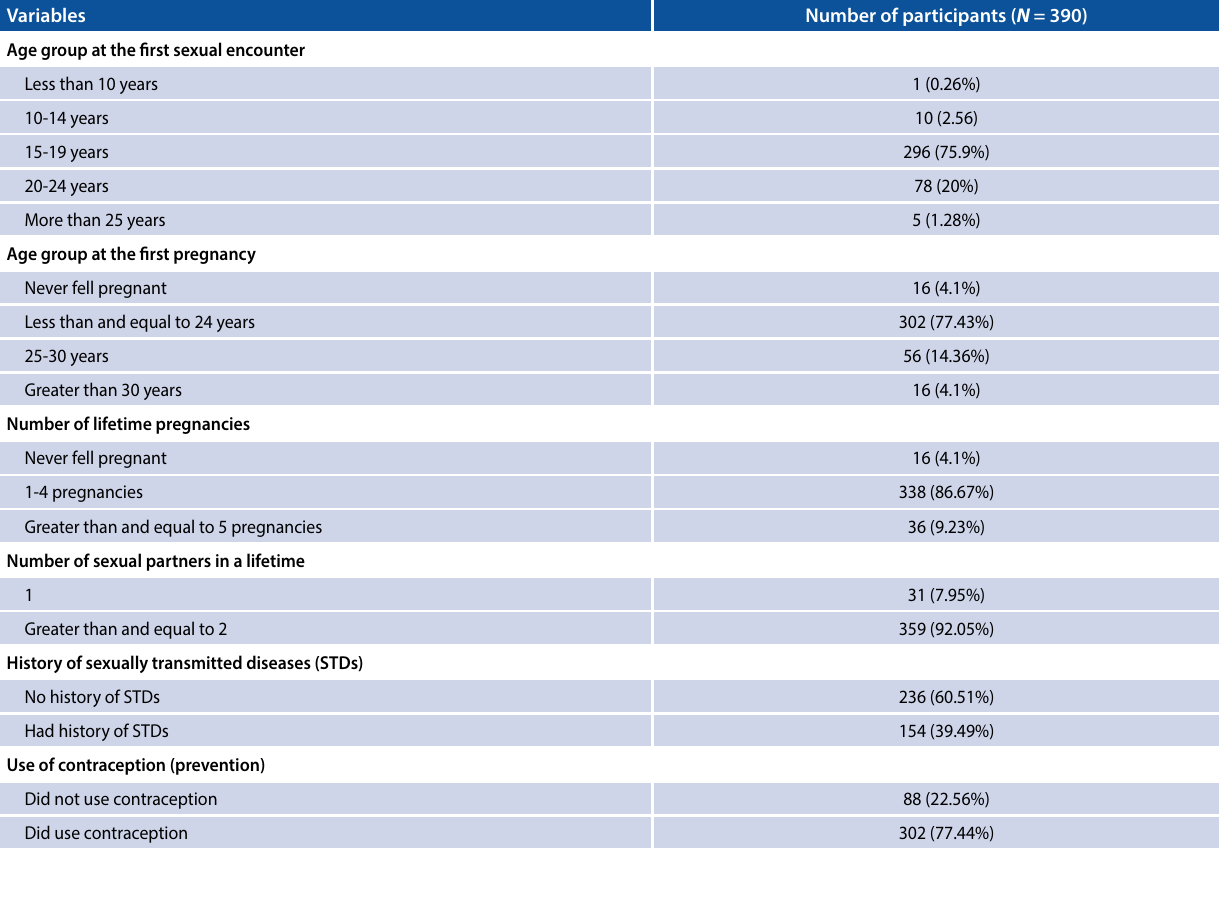
Table 1: Socio-demographic characteristics of the study’s participants Table 2: Reproductive health and sexual activities of the study’s participants